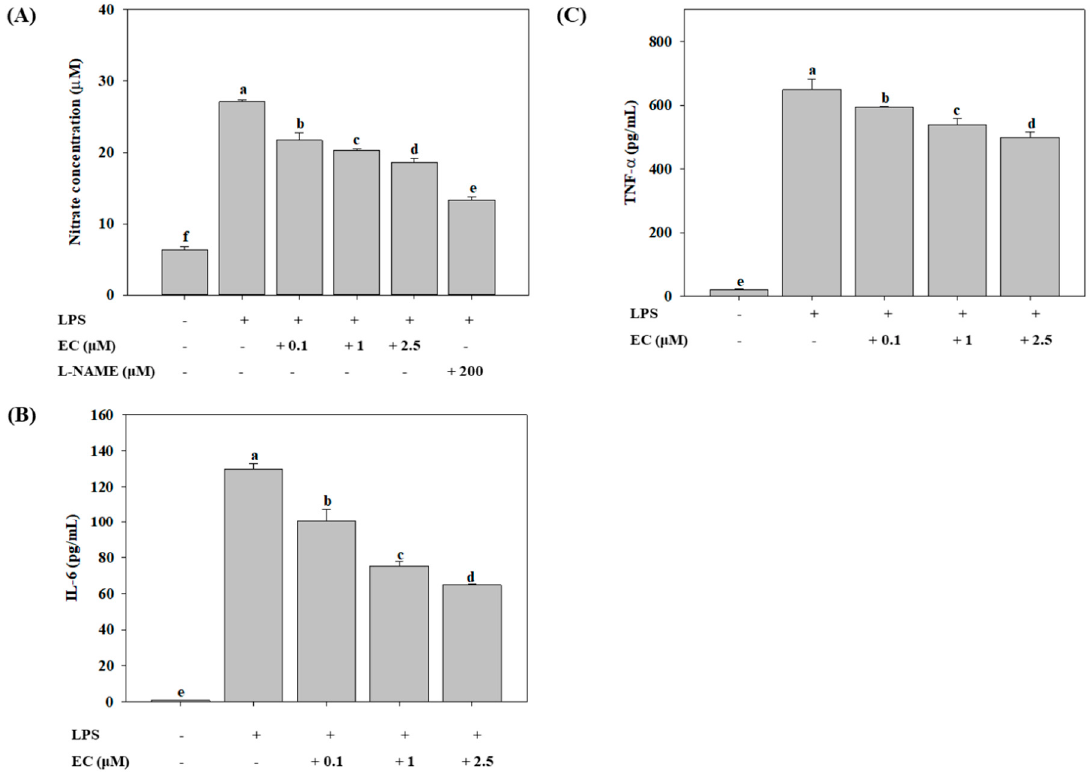
Figure 3. Effects of erinacine C (EC) on LPS-induced production of nitric oxide ( A ; NO), interleukin 6 ( B ; IL - 6), and tumor necrosis factor alpha ( C ; TNF- α ) in BV2 microglial cells. Cells (1 × 10 5 cells/mL) were pretreated with di ff erent concentrations (0.1–2.5 µ M) of EC for 1 h, after which the cells were pretreated with different concentrations (0.1–2.5 µM) of EC for 1 h, after which the cells were treated with LPS (500 ng/mL) for 24 h. Culture supernatants were collected and the production of NO, IL-6, and TNF- α was determined by an ELISA kit. L-NAME (200 µM) was used as the positive control. Values (means ± SD, n = 3) not sharing a common lower case letter are significantly different ( p < 0.05).